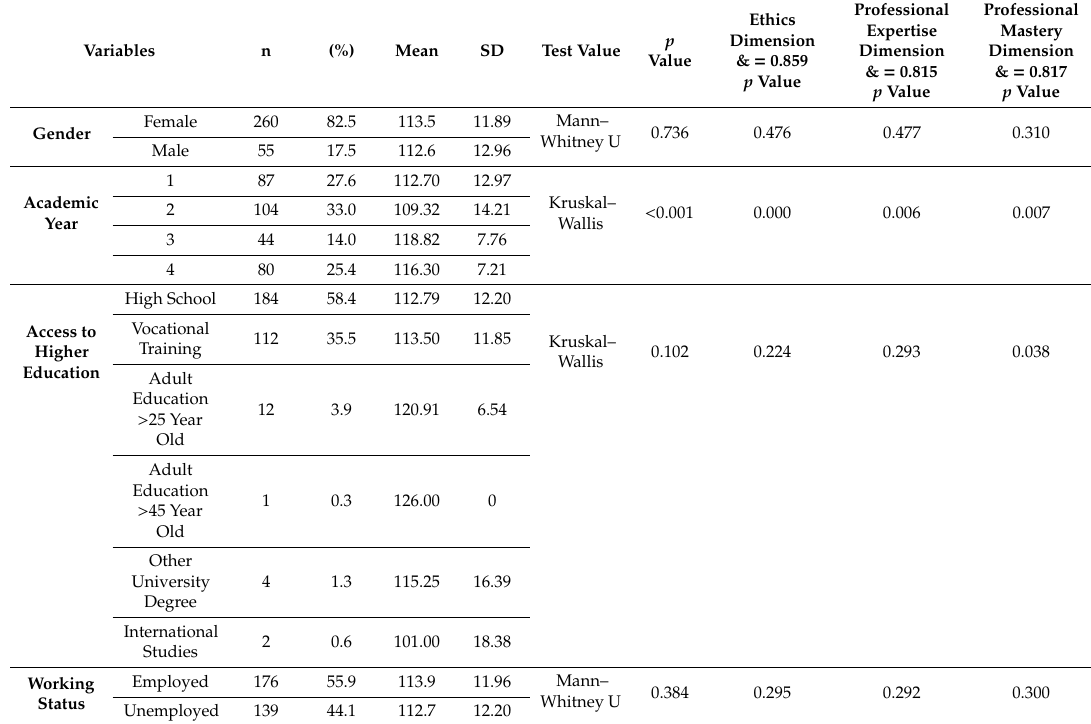
Table 2. Variables and three dimensions